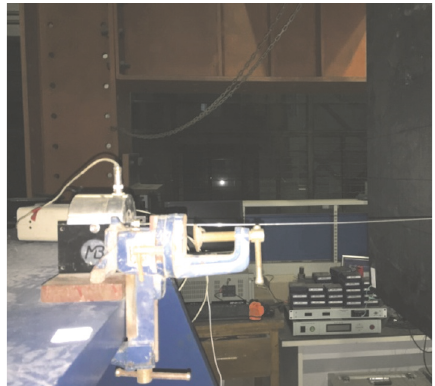
Figure 8: Position relationship between the exciter and the stiffened plate.